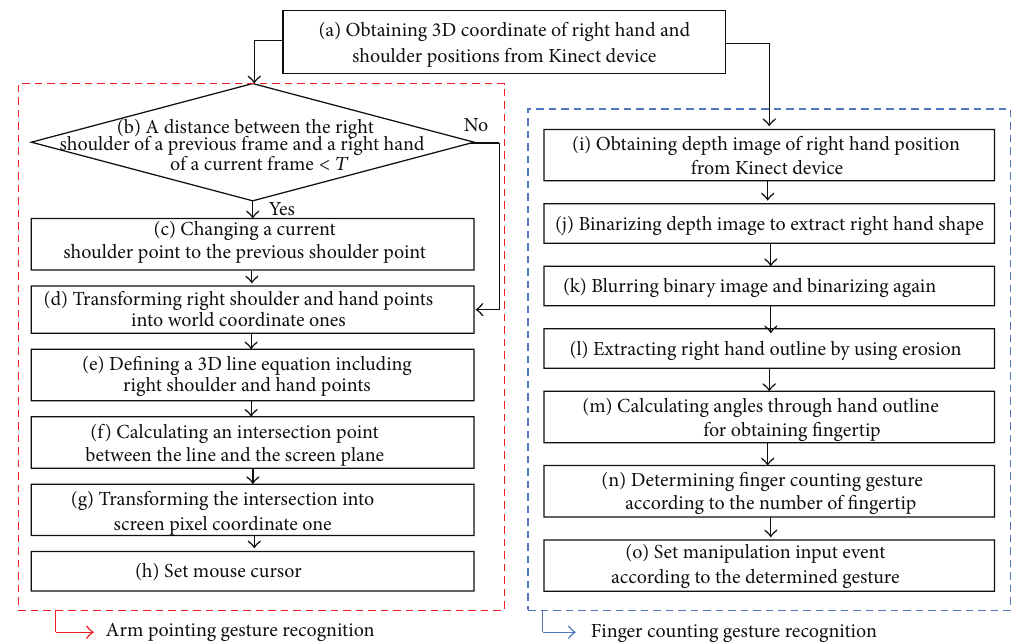
Figure 1: Flow diagram of the proposed